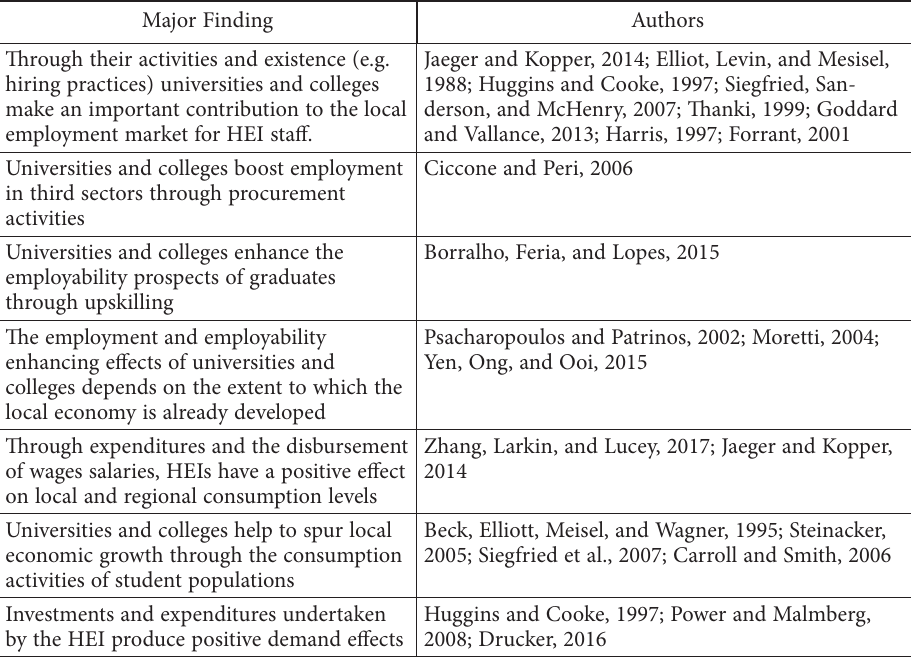
Table 2. Summary of the conclusions of studies on the first-order effects of HEIs (source: compiled by authors) Major